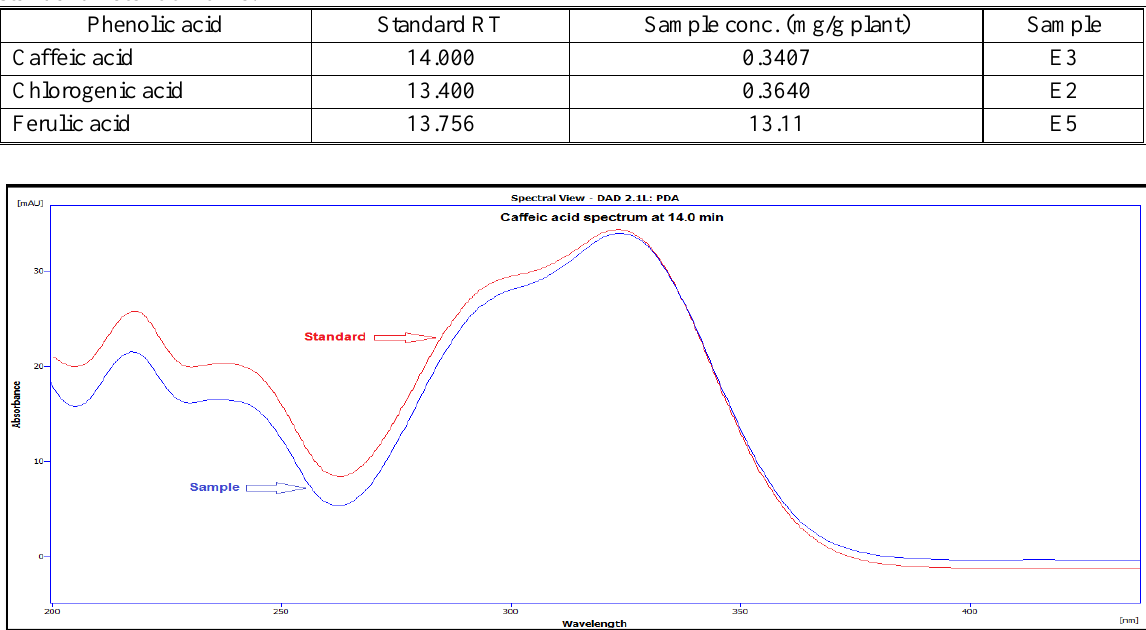
Figure 9. UV spectroscopy of standard and sample caffeic acid at